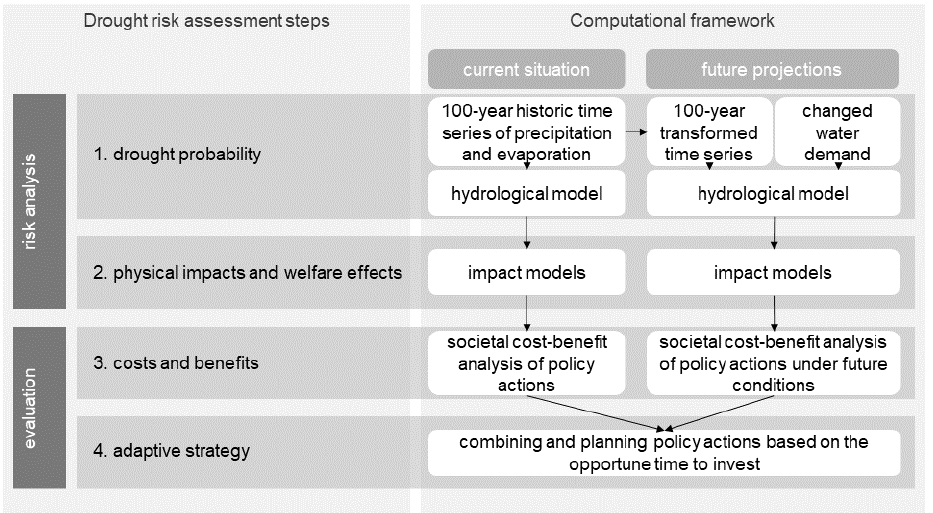
Figure 1. Framework for drought risk assessment.